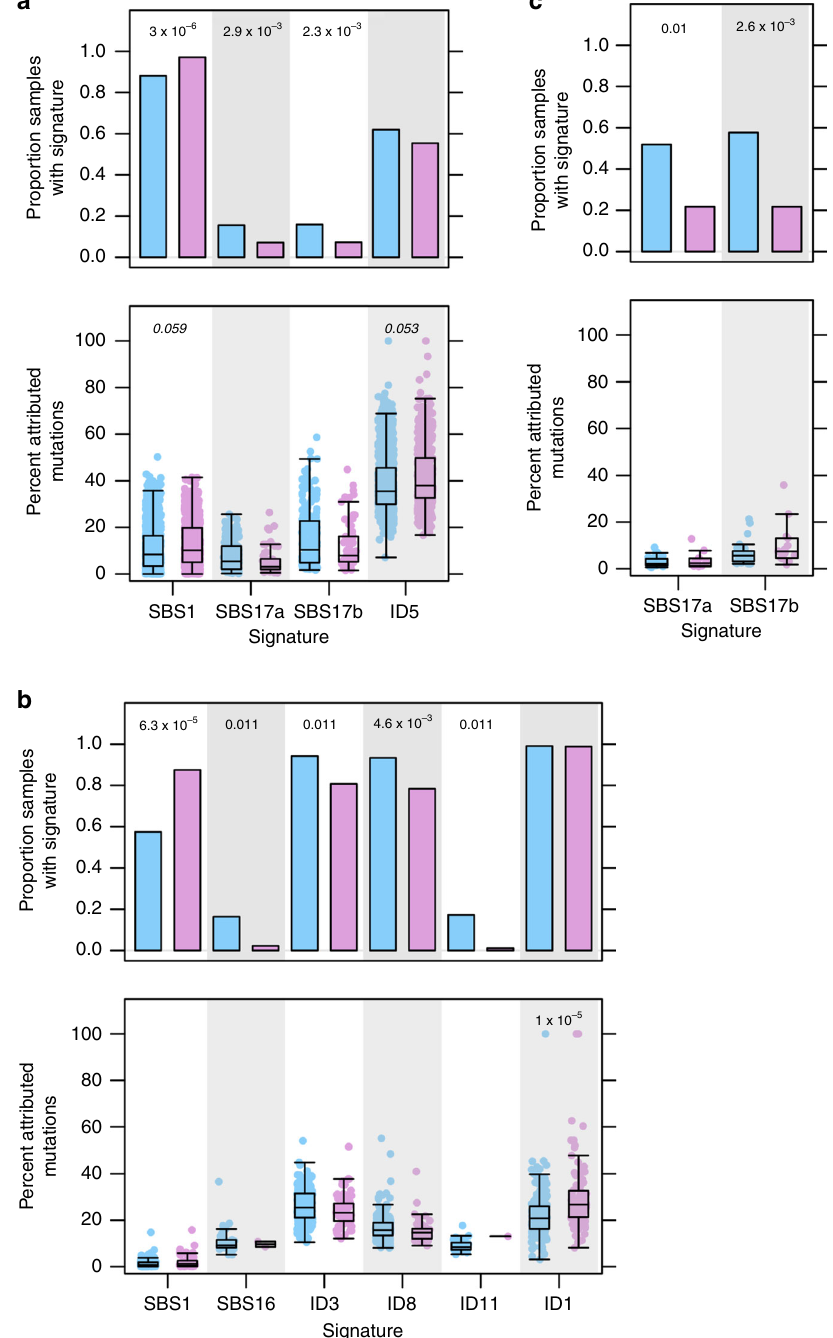
Fig. 3 Sex differences in mutational signatures related to mutational processes. Comparisons between proportions of signature-positive samples (top) and signature activity (bottom) for a pan-cancer comparisons, b liver hepatocellular cancer, and c B-cell non-Hodgkin lymphoma. FDR-adjusted q -values for multivariate logistic regression (top) and multivariate linear regression (bottom) shown only for signi fi cant comparisons. Blue shows male- and pink shows female-derived tumours. Tukey boxplots are shown with the box indicating quartiles and the whiskers drawn at the lowest and highest points within 1.5 interquartile range of the lower and upper quartiles,